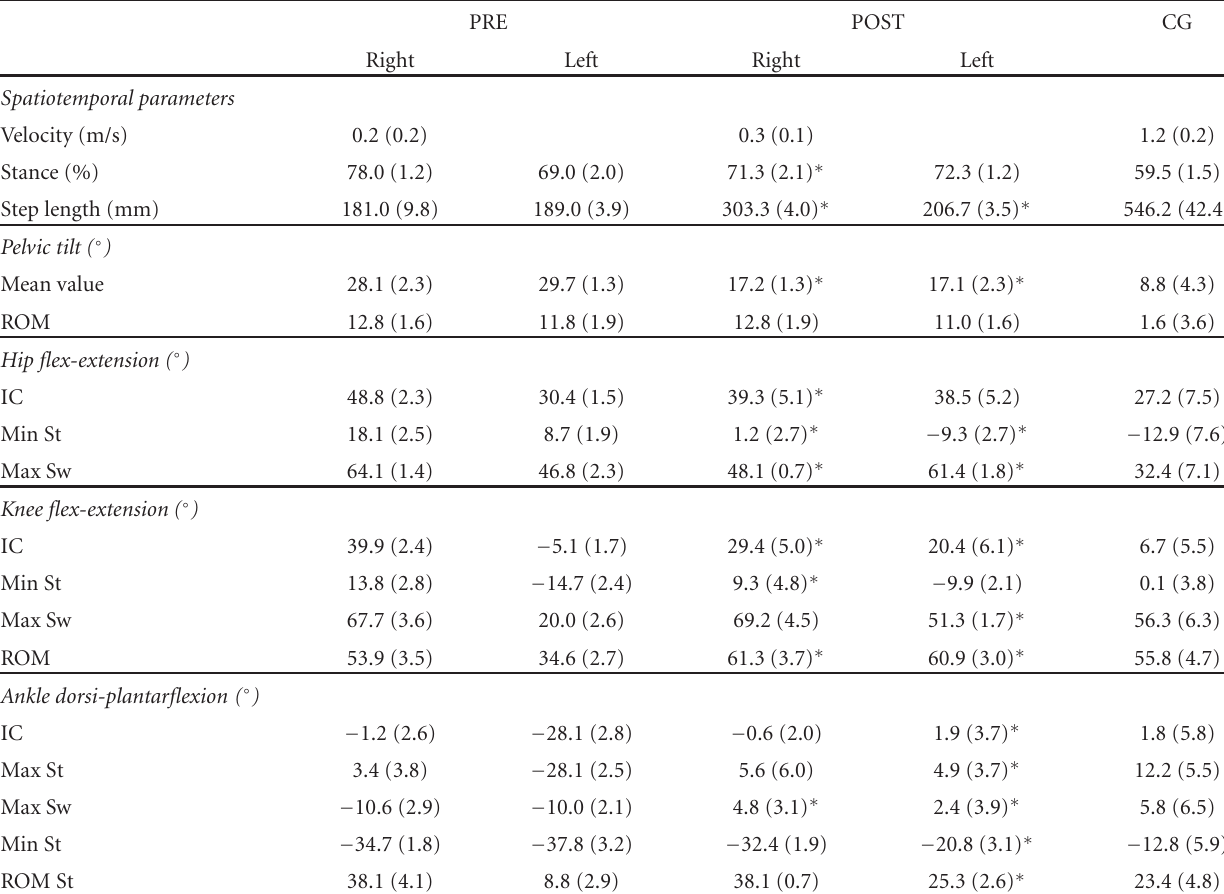
Table 1: Mean (standard deviation) values of the spatiotemporal and kinematic parameters for the child in the PRE and POST sessions and for the control group